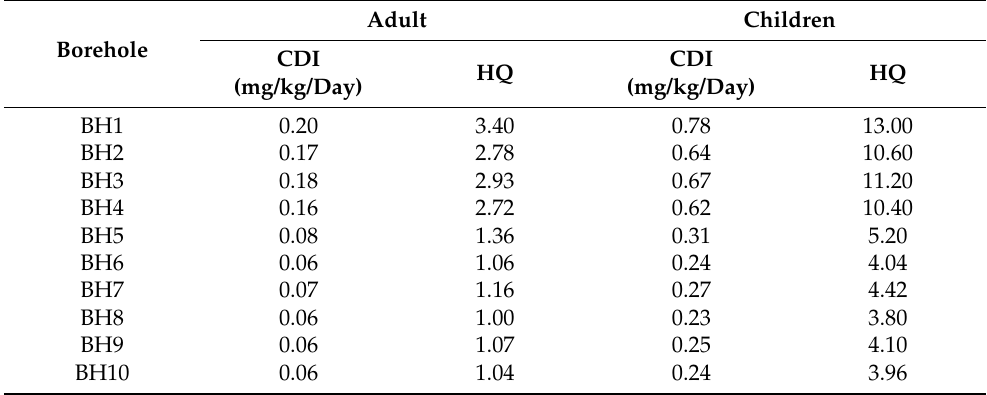
Table 9. Chronic daily intake (CDI) of fluoride and hazard quotient (HQ) for adults and children for noncarcinogenic risk